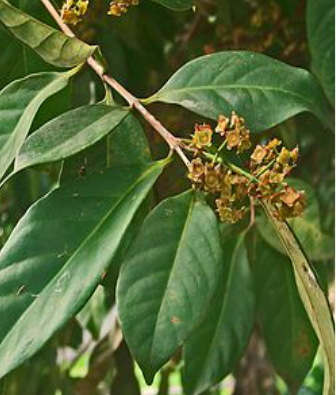
Figure 1. Syzygium polyanthum (Wight.).